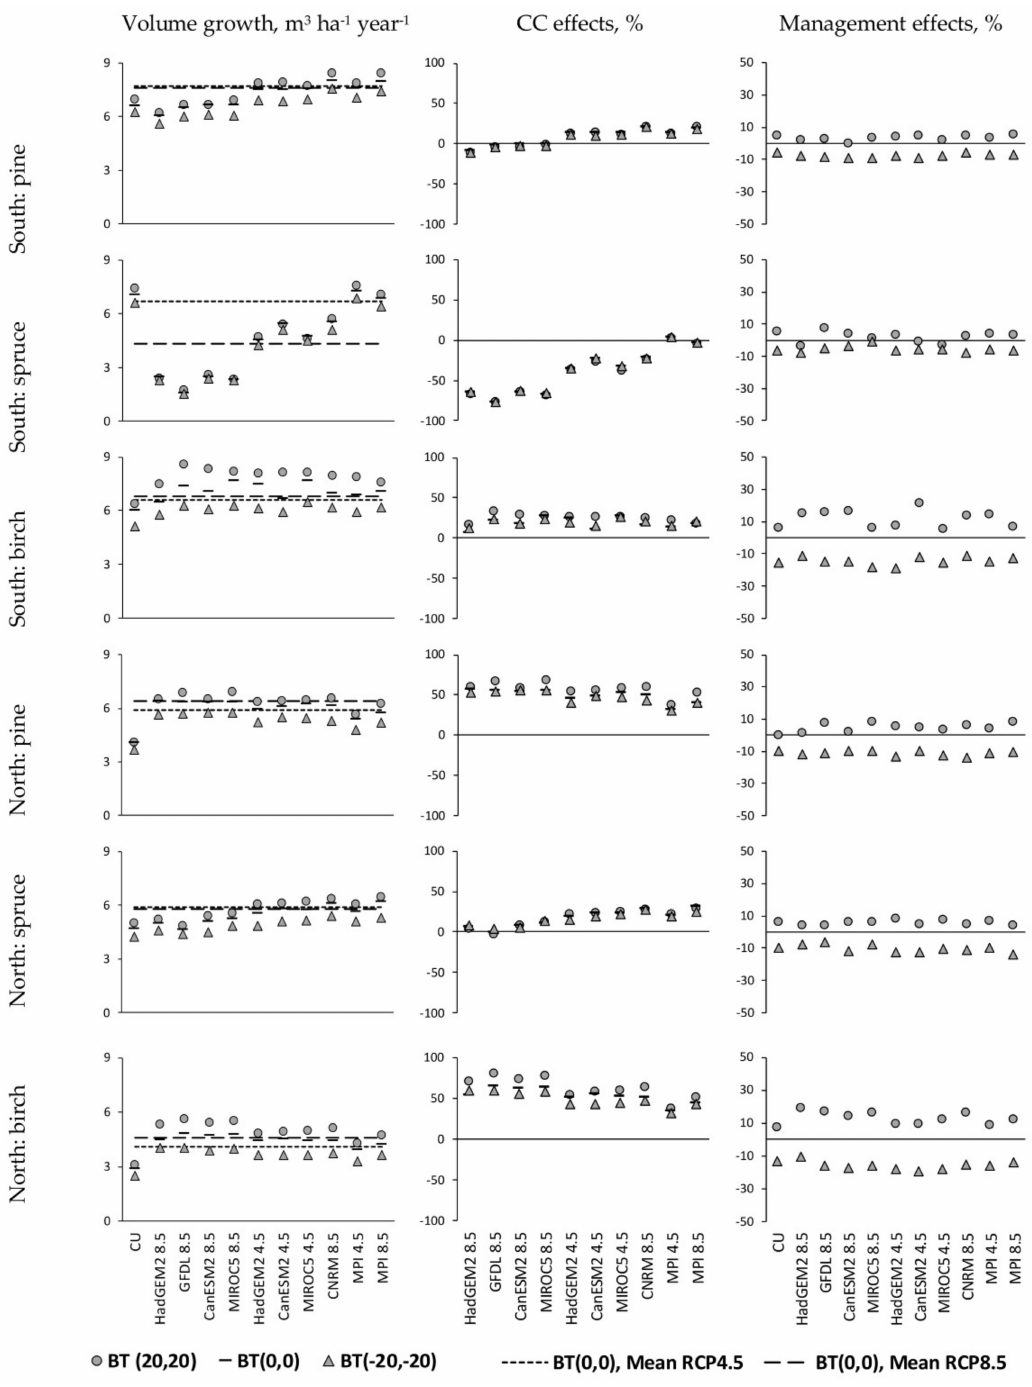
Figure 2. The annual stem volume growth (m 3 ha − 1 year − 1 ) in Scots pine, Norway spruce and Silver birch stands with different management regimes under the current climate (CU, period 1981-2010) and individual climate change, GCMs, projections (shown in table 2), under the RCP4.5 and RCP8.5 forcing scenarios, in southern and northern Finland. As a comparison, absolute values (on the left) for the multi-model means of the GCMs under the RCP4.5 (Mean RCP4.5) and RCP8.5 (Mean RCP8.5) forcing scenarios are